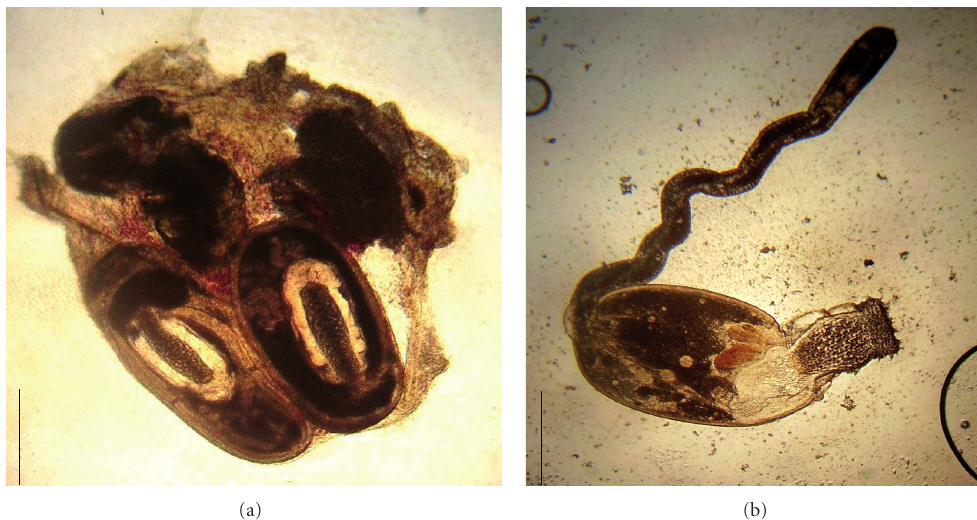
Figure 5: (a) Acanthocephala cyst (intact), (b) mechanically excysted Acanthocephala juvenile. Scale bar = 0.5mm.